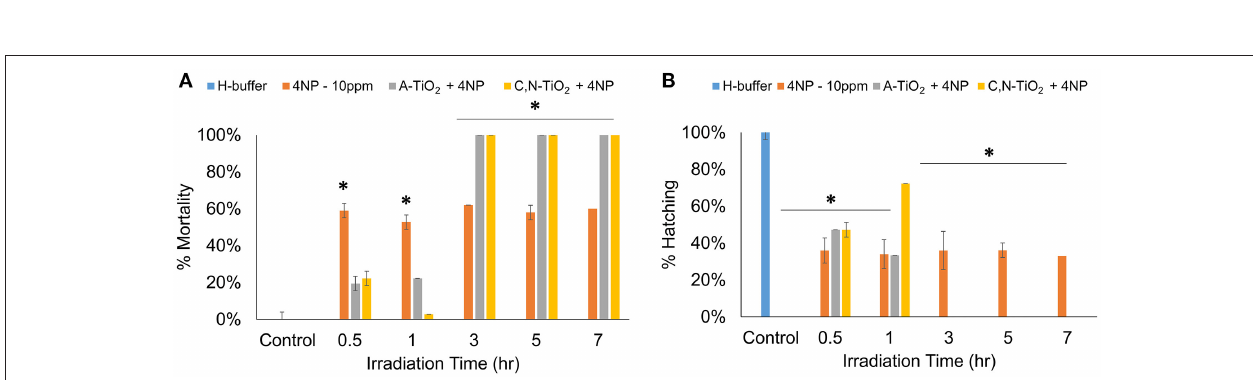
Frontiers in Chemistry |